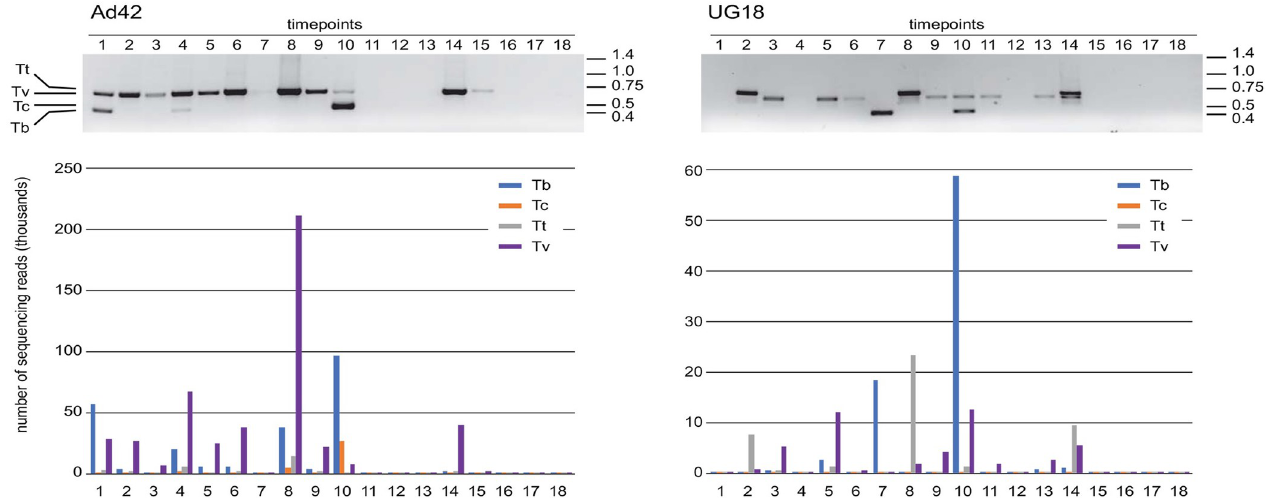
Fig 1. Detection of trypanosome species in cattle over 18 time points spanning two years. Two individuals are shown: Ad42 from Adidome and UG18 from Accra. Comparison of analysis by agarose gel electrophoresis (top) and read count after massively parallel amplicon sequencing (bottom). For the agarose gels, DNA was visualised using ethidium bromide and the image is shown as a negative. The species are indicated (Tt, T . theileri , Tv, T . vivax ; Tc, T . congolense ; Tb, T . brucei ) and DNA size standards (kbp) are shown to the right of each gel. The read counts are shown for each species at each time point, note that the y-axis scales are different for each cow.